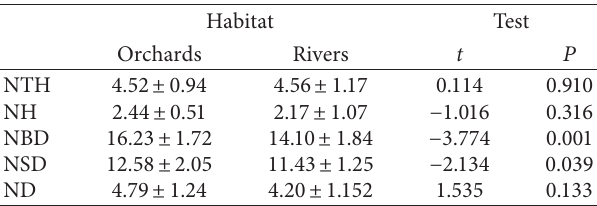
Figure 2: Nesting trees used by turtle doves in both farmlands and riparian sites. Table 1: Comparisons of nest placement parameters and nest dimensions of turtle doves between apple orchards and riparian habitats, tested using t